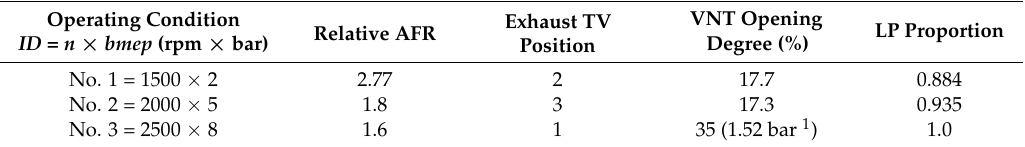
Table 4. Optimal control strategies for NO X and fuel consumption reduction in tested steady state operating conditions.